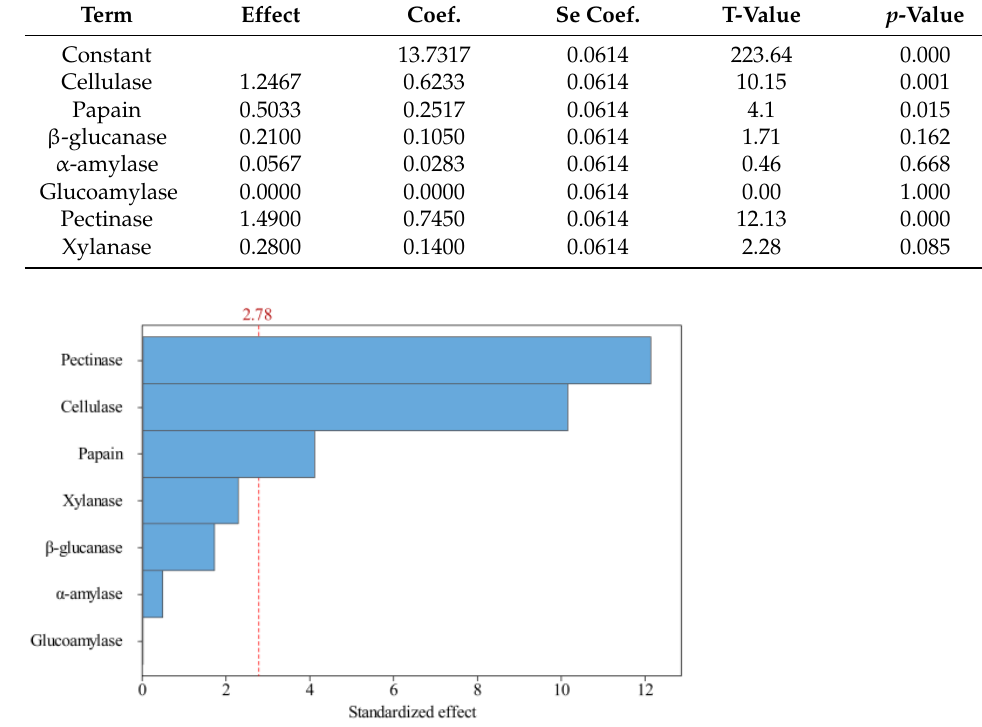
Figure 3. Pareto graph showing the effects of variables (different enzymes) on the peony seed oil extraction rate (alpha =